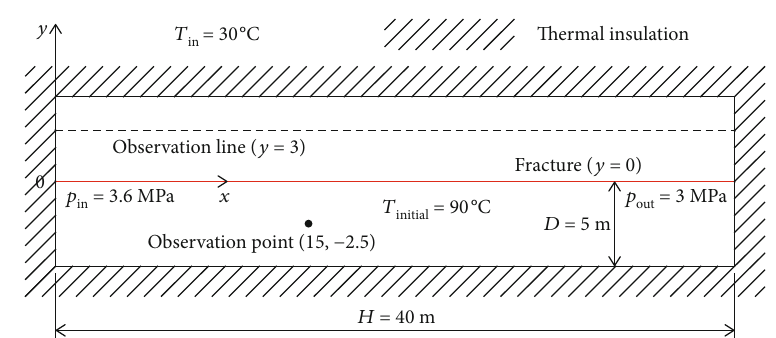
Figure 3: Geometric model of heat transfer in a single fractured